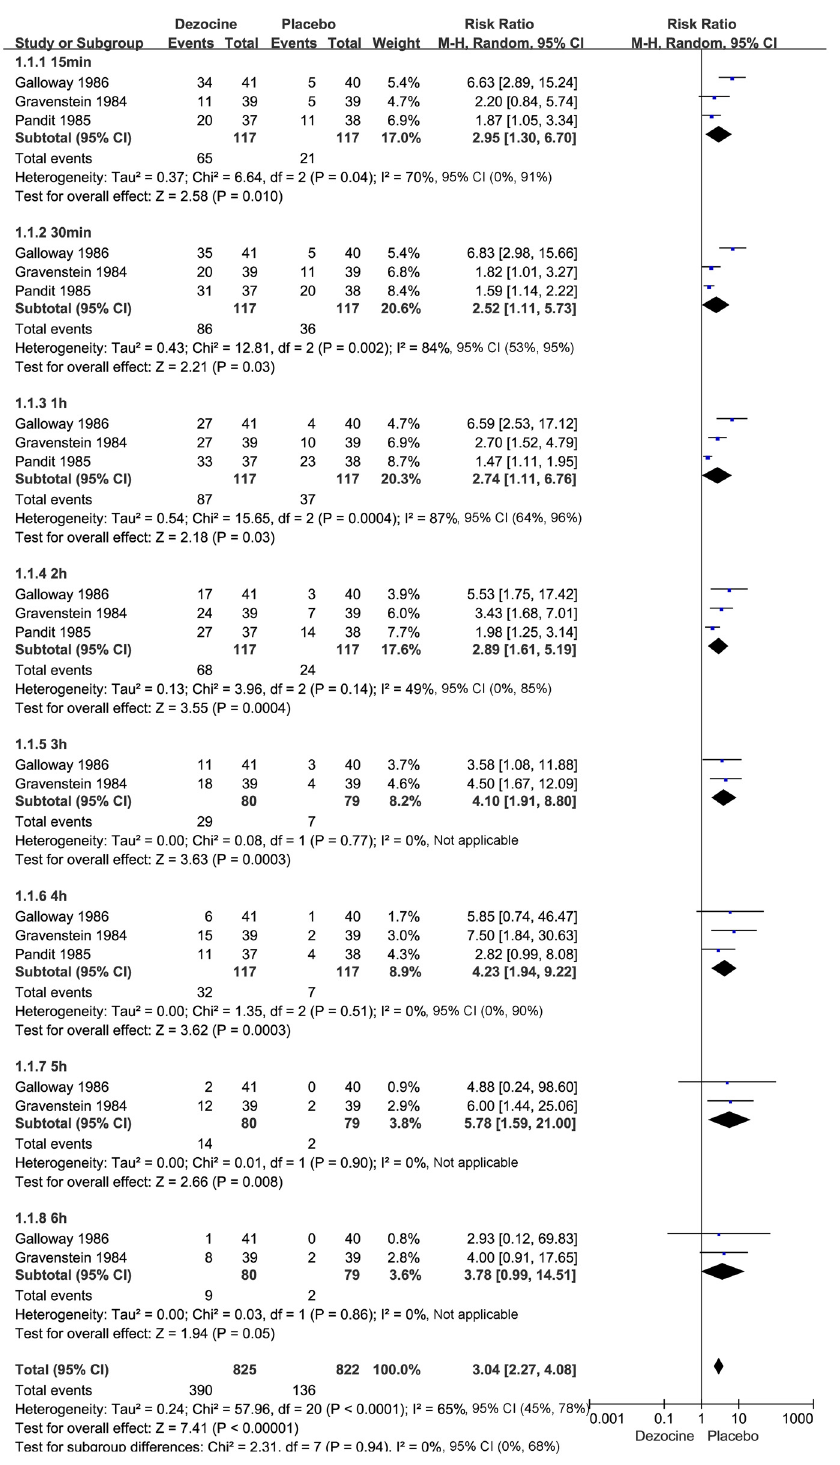
Fig 2. Forest plot of the effect of dezocine versus placebo on postoperative pain relief (at least 50%) within 6 h after surgery. RR = relative risk; and CI = confidence interval.